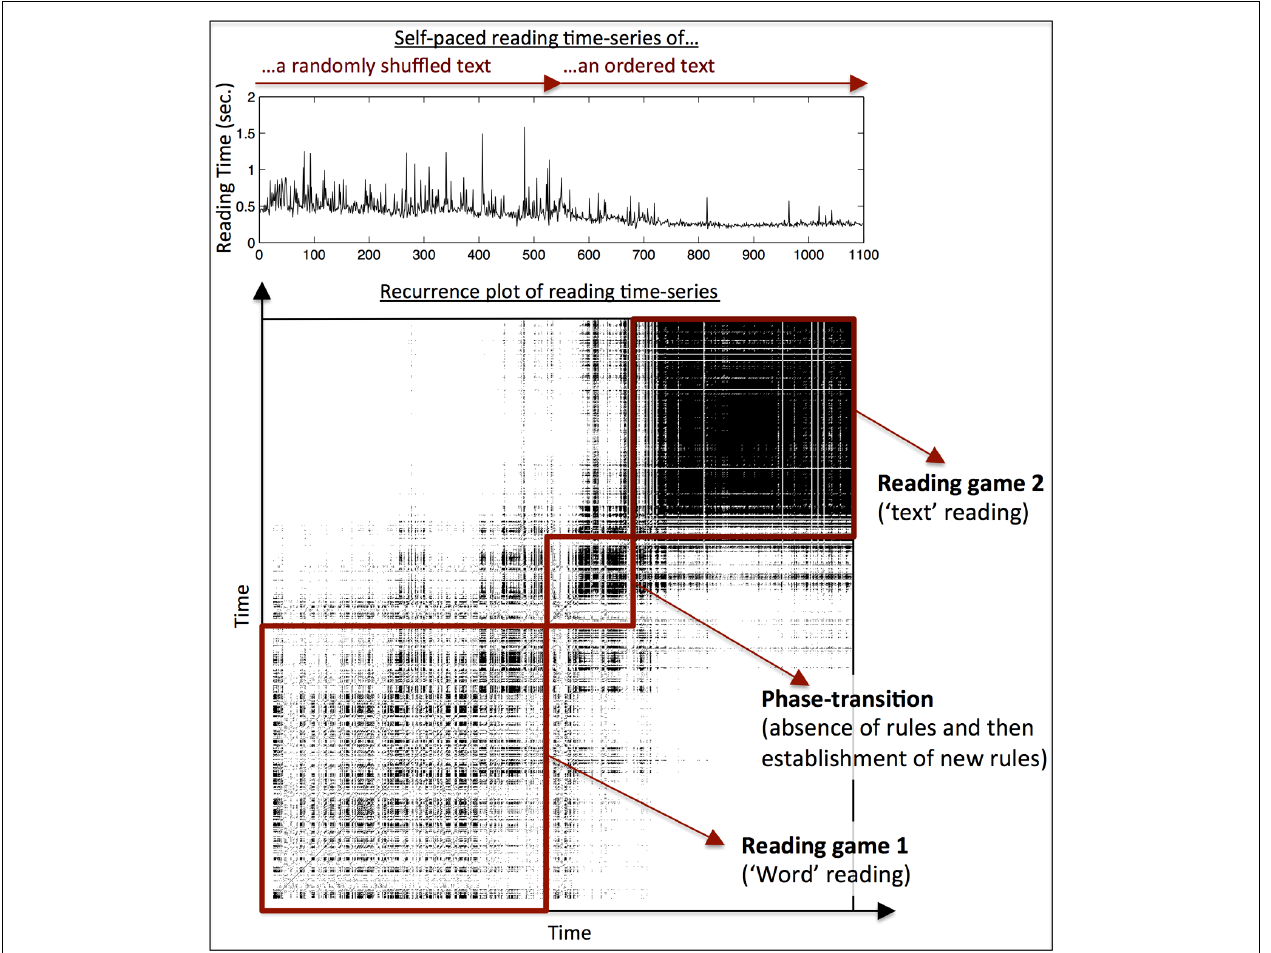
(as evident by black areas in the plot). Furthermore, the transition from random word reading to connected text reading is neither instantaneous, nor smooth, as indicated by the transition-phase that connects the two reading conditions. Lastly, it can be seen that random word reading and text reading are different in terms of how they are temporally organized, as the off- diagonal areas in the upper-left and lower right area are white, indicating no shared temporal structure between word and text